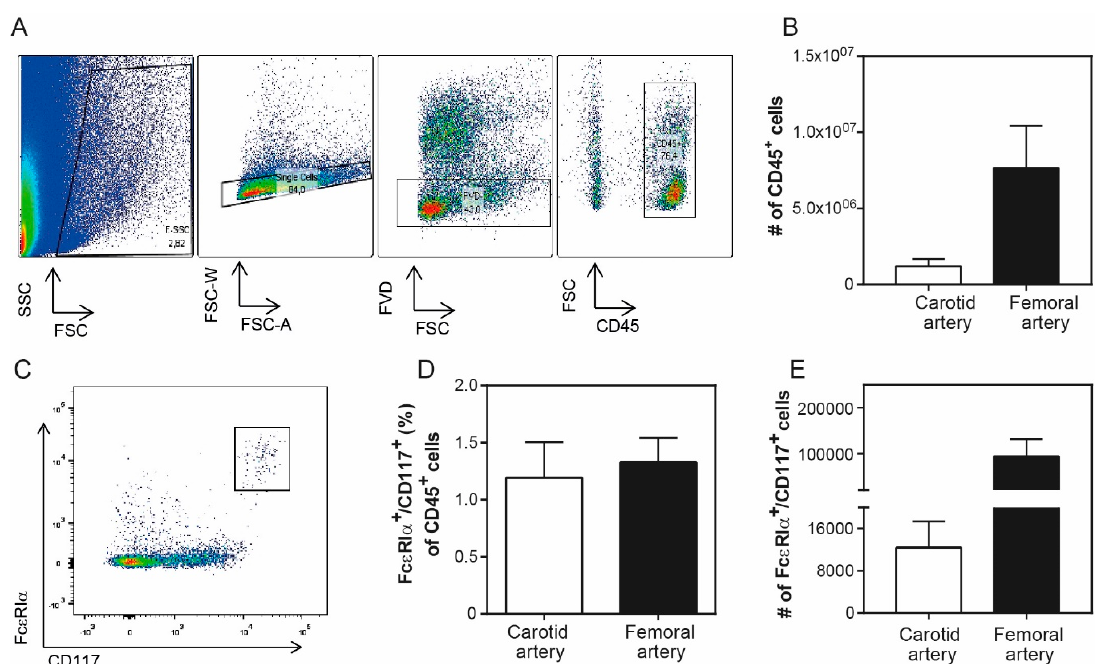
Figure 2. Mast cell content in human plaques. ( A ) Human plaque cell gating strategy using flow cytometry. Human intraplaque cells were selected based on their size and area. The viable cells were further separated according to the negative incorporation of fluorescent viability dye (FVD − ). Immune cells were detected using the pan-leukocyte marker CD45 + . ( B ) Both the femoral and carotid artery plaques contain CD45 + immune cells. ( C ) The human mast cell population was further classified using antibodies against the characteristic markers Fc ε RI α + and CD117 + . ( D ) Mast cell percentage inside human plaques isolated upon endarterectomy surgeries in carotid and femoral arteries. ( E ) Absolute mast cell numbers of human carotid and femoral artery samples. The data are depicted as mean ± standard error of the mean (SEM); ( n = 10–12/grp).